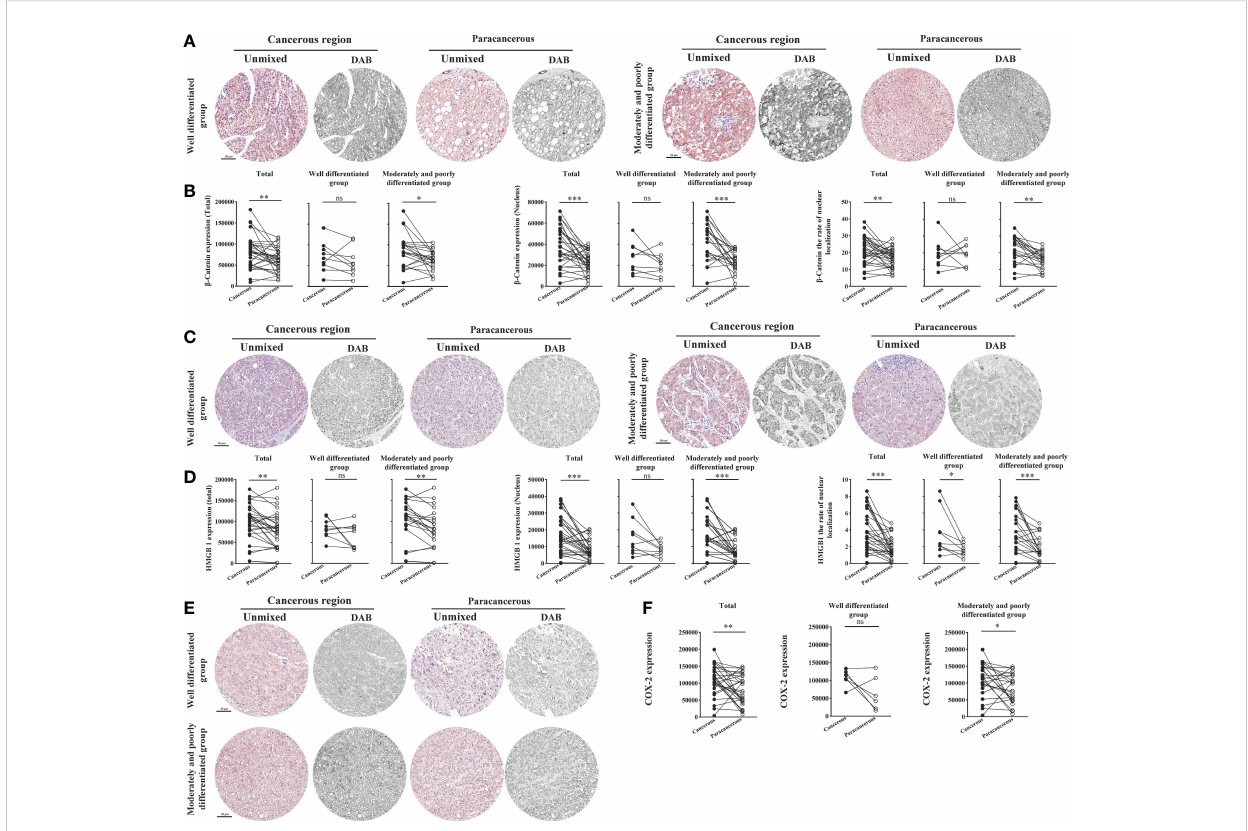
FIGURE 6 Immunohistochemical staining of b -catenin, HMGB1, and COX-2 proteins in liver cancer tissues and their quantitative images. (A) Representative image of immunohistochemical staining of the b -catenin protein in liver tissues. (B) Quantitative multispectral image of the b -catenin protein. (C) Representative image of immunohistochemical staining of the HMGB1 protein in liver tissues. (D) Quantitative multispectral image of the HMGB1 protein. (E) Representative image of immunohistochemical staining of the COX-2 protein in liver tissues. (F) Quantitative multispectral image of the COX-2 protein. The experimental data are expressed as the mean ± SEM. Compared to paracancerous regions, * p < 0.05; ** p < 0.01; *** p < 0.001. Scale bar, 50 µm. ns, not